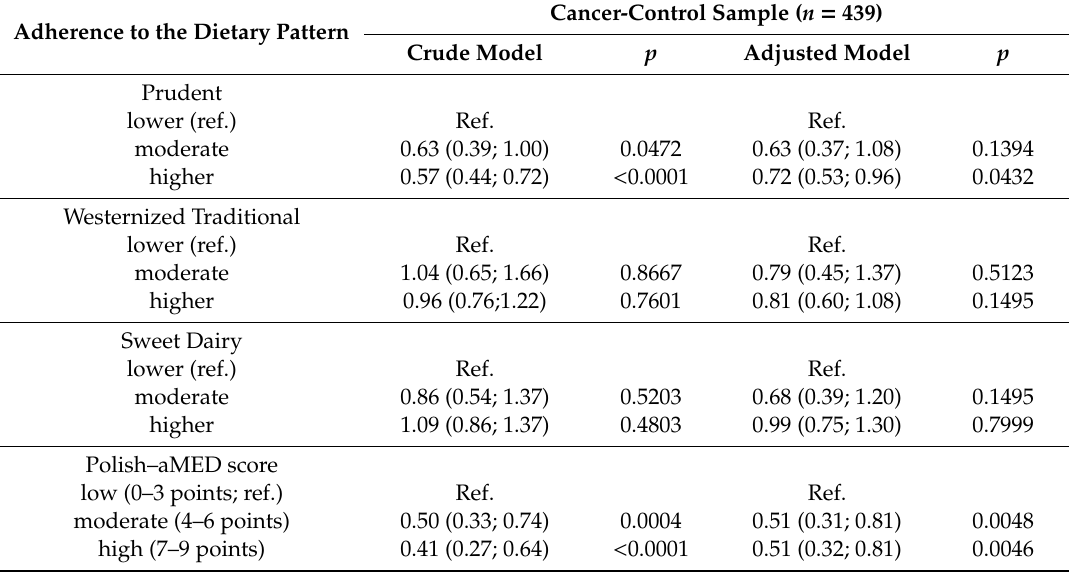
Table 4. Odds ratios (95% confidence intervals) of lung cancer risk by adherence to the dietary patterns. Adherence to the Dietary